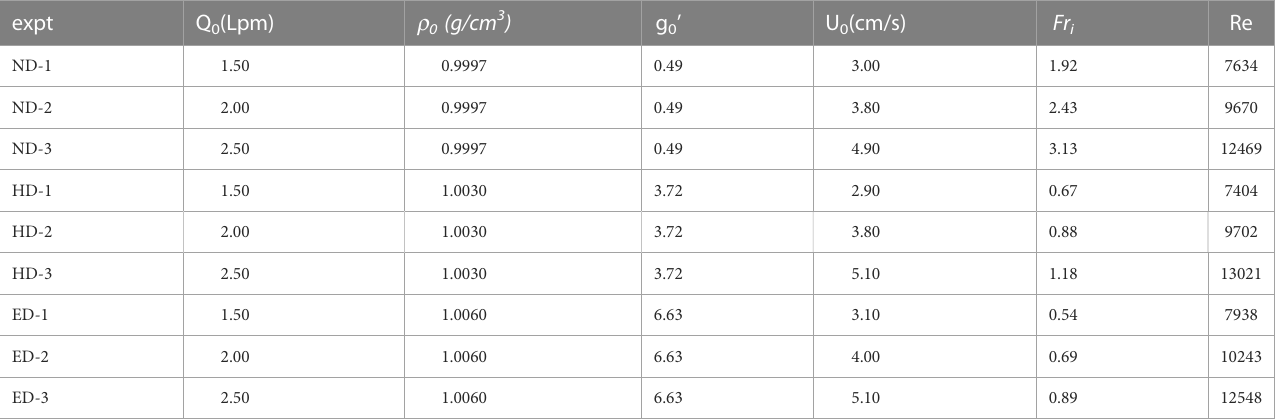
TABLE 1 The parameters of the